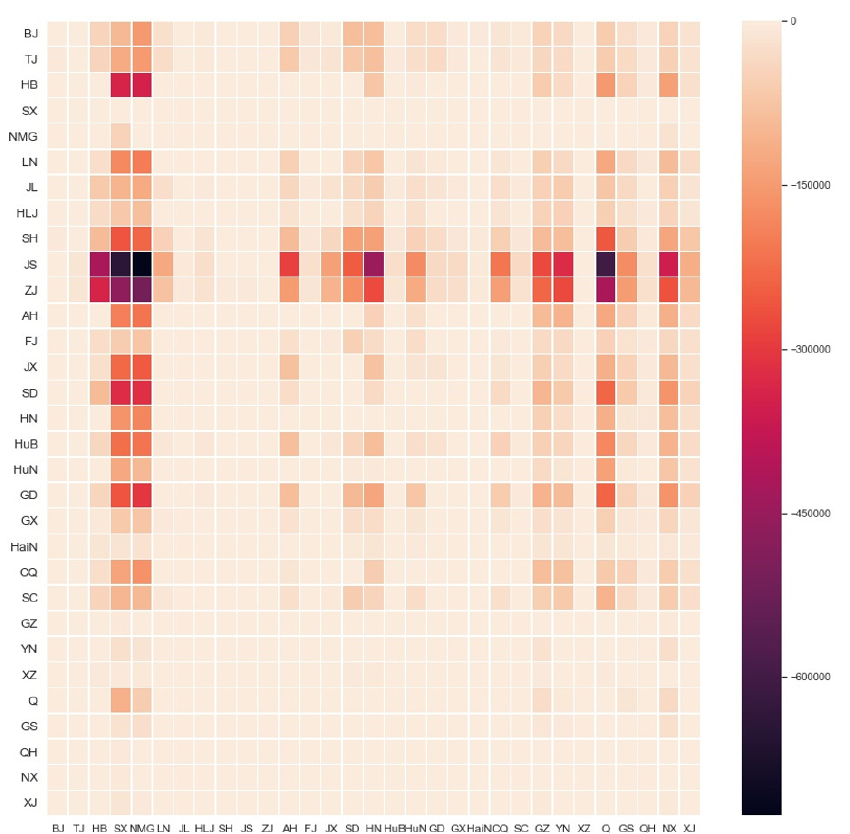
Figure 3. Net movement matrix of SO 2 (tons) between provinces in